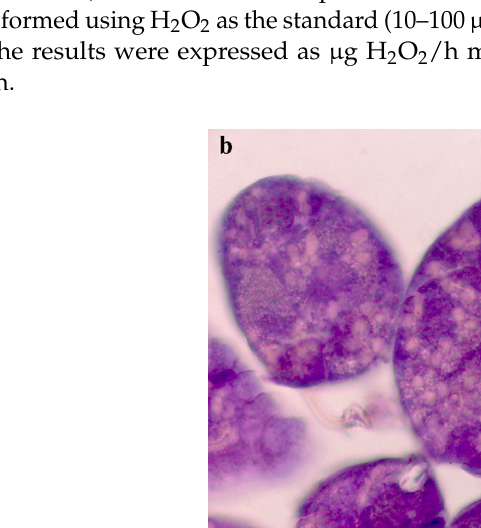
Figure 1. Adult honeybees hypopharyngeal gland tissue microscopic slides used for acinar diameter measuring; ( a )–10× magnification, ( b )–40× magnification.